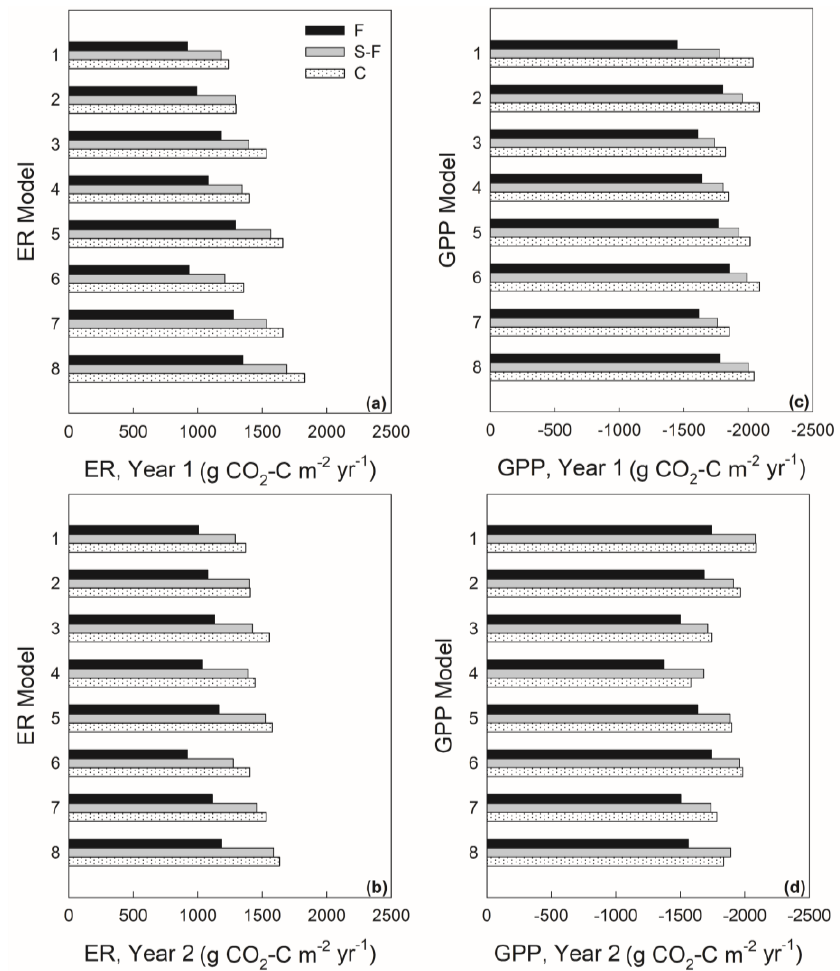
Figure 7. (a, b) Annual ecosystem respiration (ER) and (c, d) annual gross primary production (GPP) estimates with different ER and GPP models (see Tables 1 and 2) at the different WTD treatments, i.e., flooded (F), semi-flooded (S-F) and control (C). Data are shown for each study